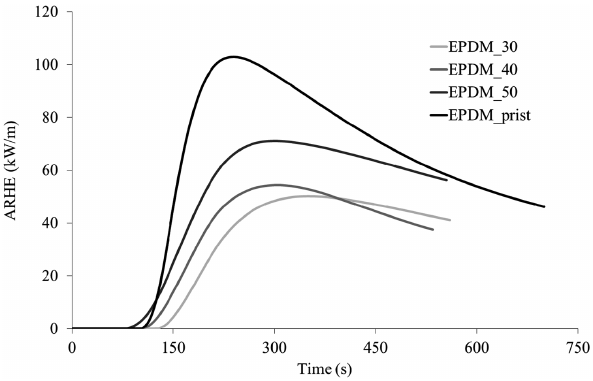
Figure 6: Averaged heat release rate (ARHE) curves of samples